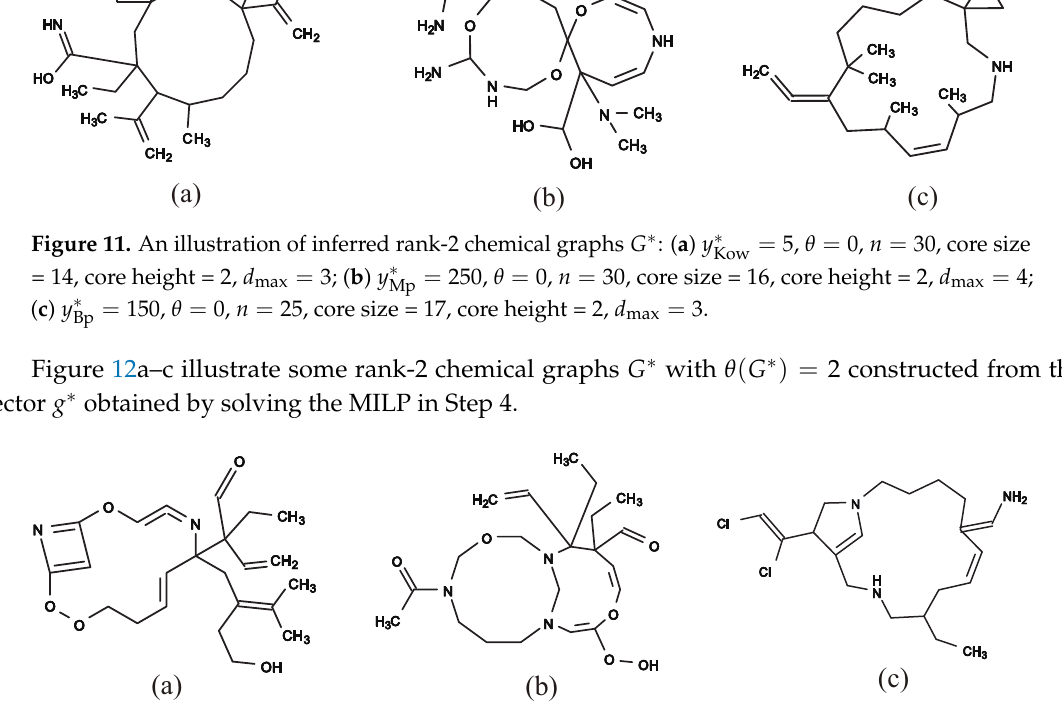
= 5, θ = 2, n = 30, core size Figure 12. An illustration of inferred rank-2 chemical graphs G ∗ : ( a ) y ∗ Kow = 250, θ = 2, n = 30, core size = 17, core height = 2, d max = 3; = 15, core height = 5, d max = 4; ( b ) y ∗ Mp = 150, θ = 2, n = 25, core size = 17, core height = 3, d max = ( c ) y ∗ Bp